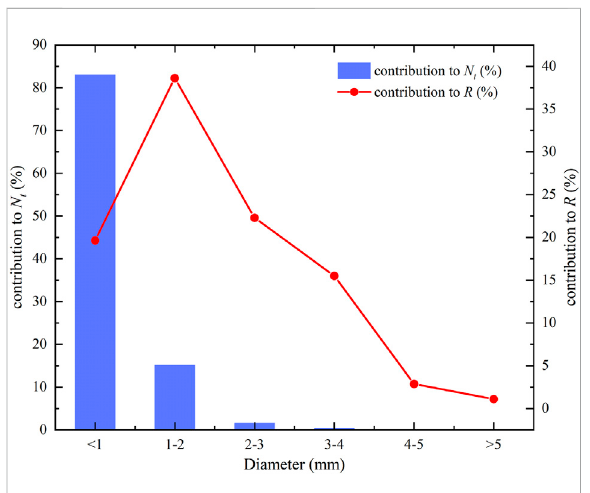
FIGURE 4 Relativecontributionofeachsizeclasstotherainrate R (solid redline)andtotaldropcontribution N t (bluehistogram)inthehead watershed at the Urumqi River basin.